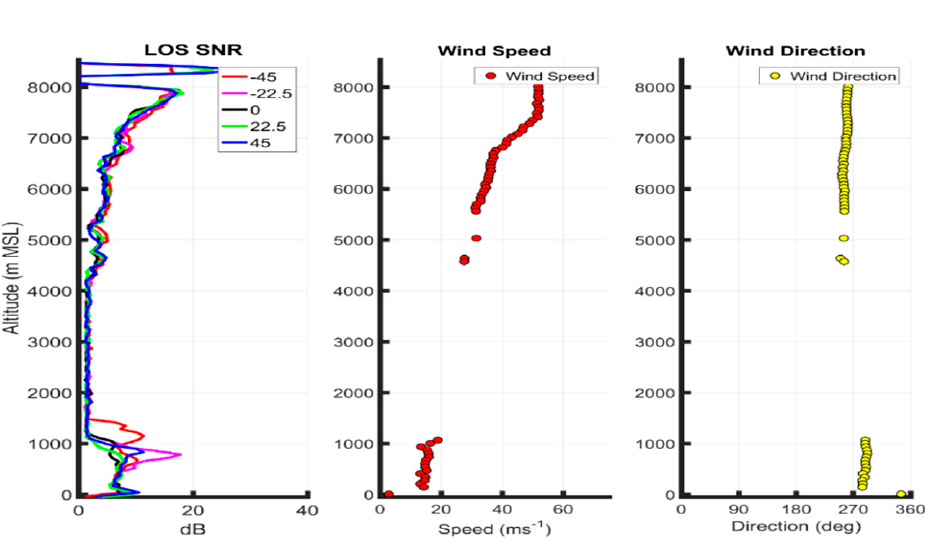
Table 5. DAWN measurements, precision and resolutions.